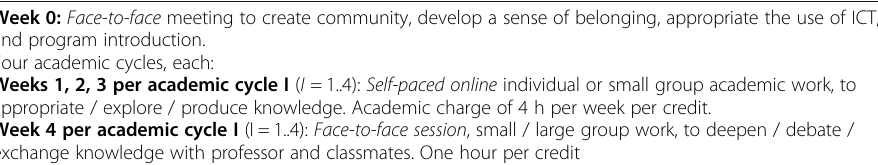
Table 3 Time mix of learning modalities in a bLearning graduate program (Source: Uniandes) Week 0: Face-to-face meeting to create community, develop a sense of belonging, appropriate the use of ICT, and program introduction. Four academic cycles, each: Weeks 1, 2, 3 per academic cycle I ( I = 1..4): Self-paced online individual or small group academic work, to